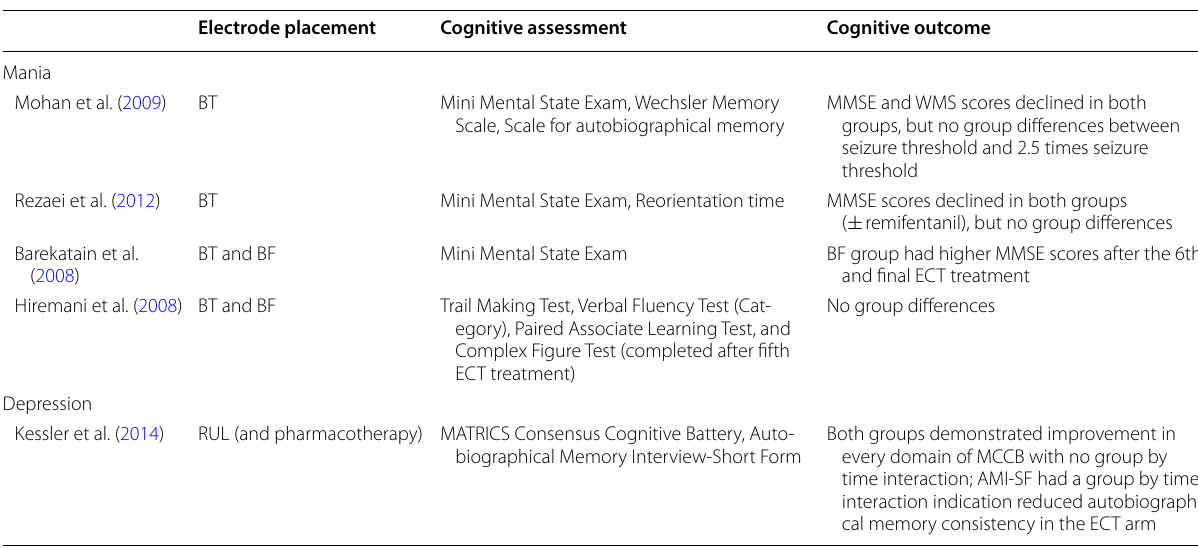
Table 4 Electrode placement and